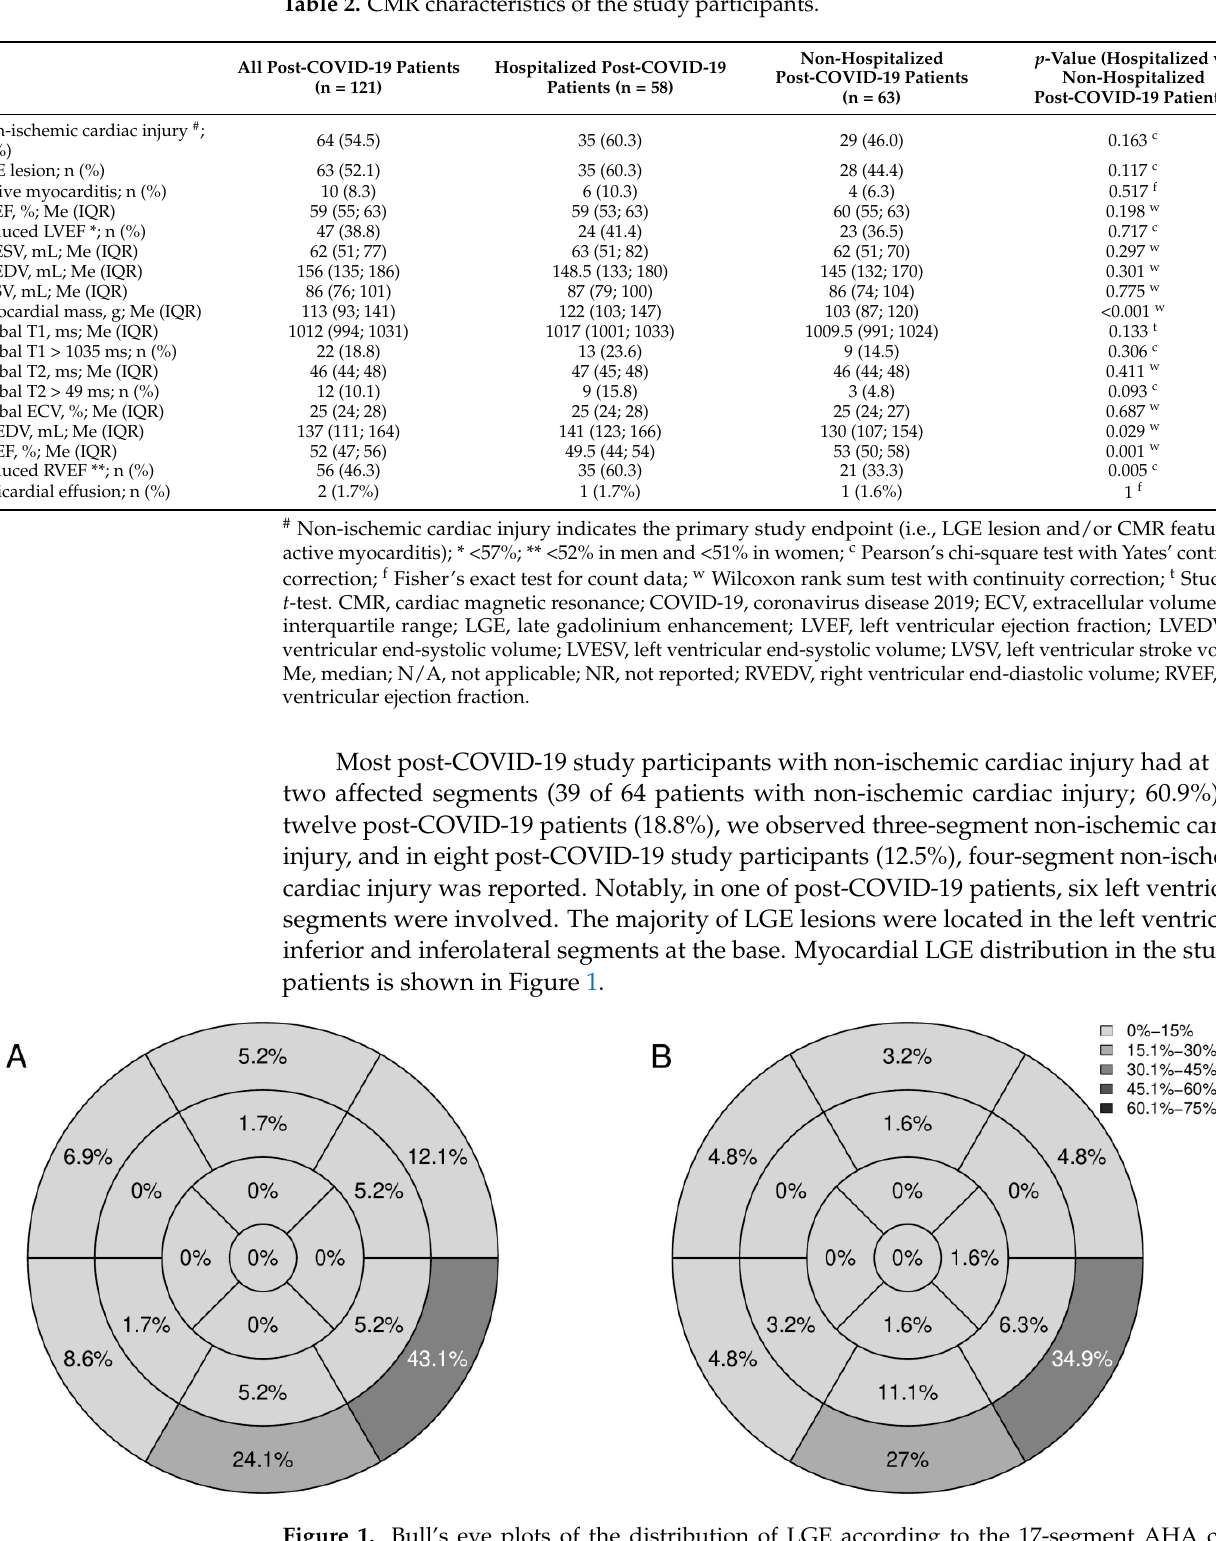
Figure 1. Bull’s eye plots of the distribution of LGE according to the 17-segment AHA classification: rates of segments with LGE in hospitalized ( A ) and non-hospitalized ( B ) post-COVID-19 patients. AHA, American Heart Association; COVID-19, coronavirus disease 2019; LGE, late gadolinium enhancement.